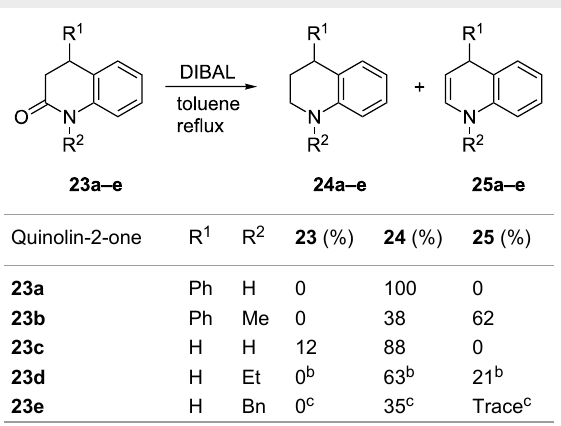
Table 2: DIBAL reductions of quinolin-2-ones 23a – e using the opti- mised method to synthesise 22 . a